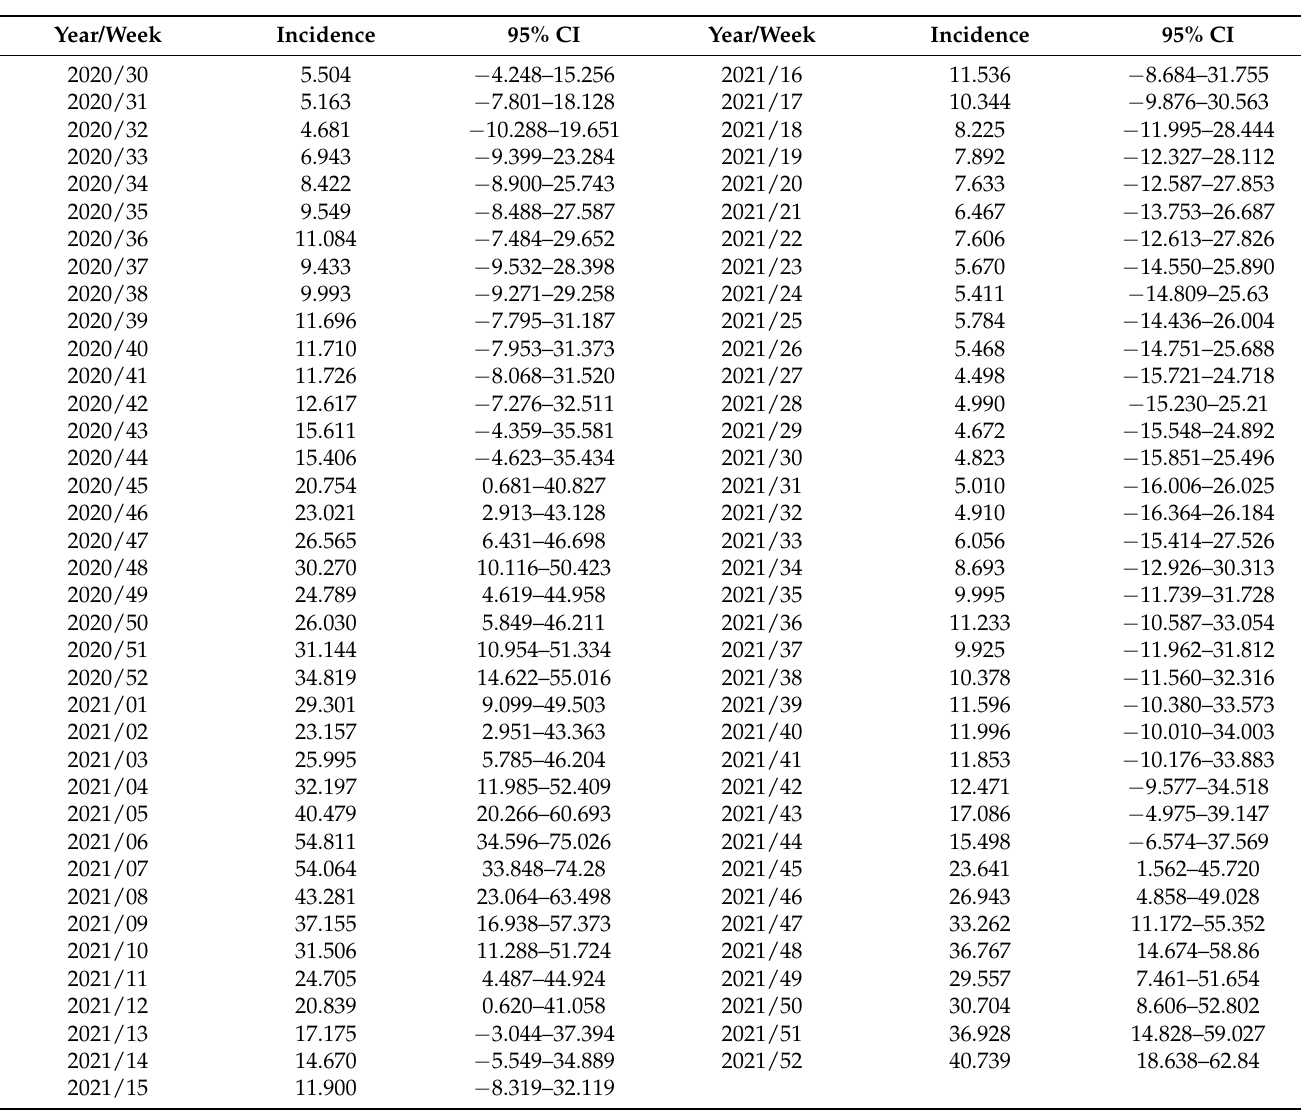
Table 4. Predictive value of ILI incidence (per